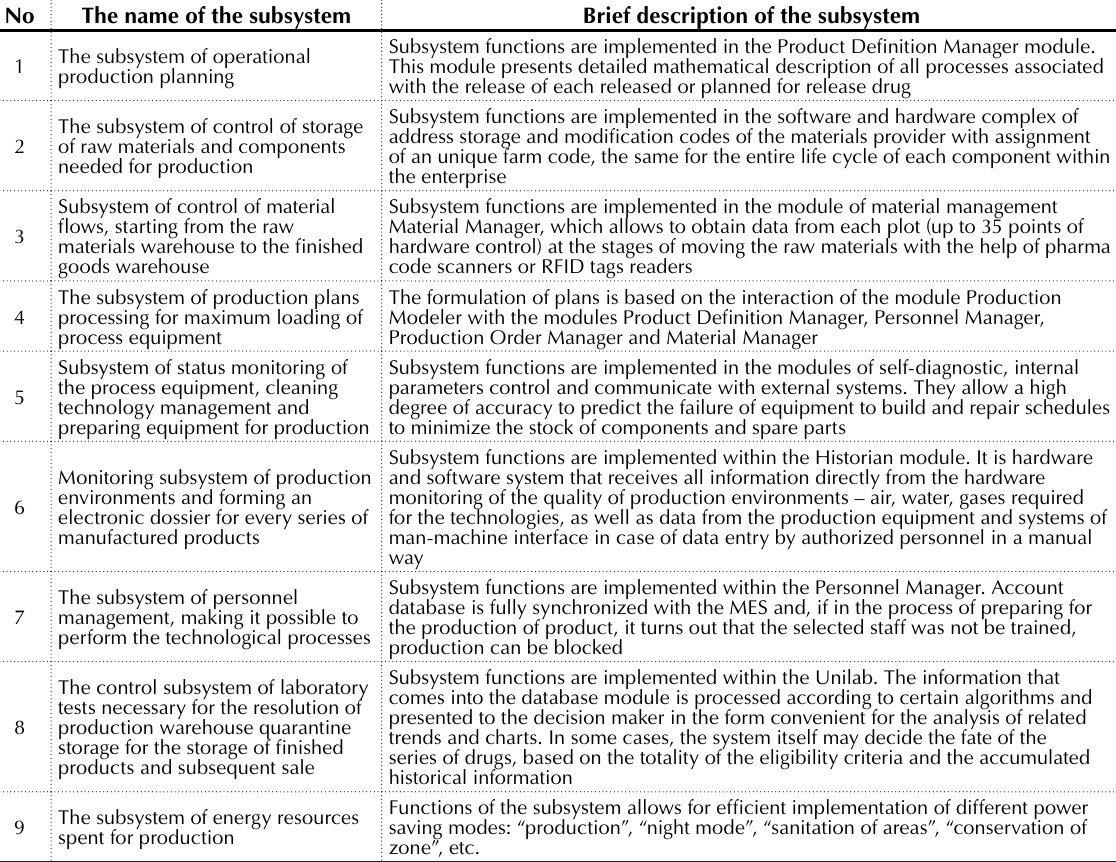
Table 1. Functional subsystems of the embedded MES based on the SIMATIC IT